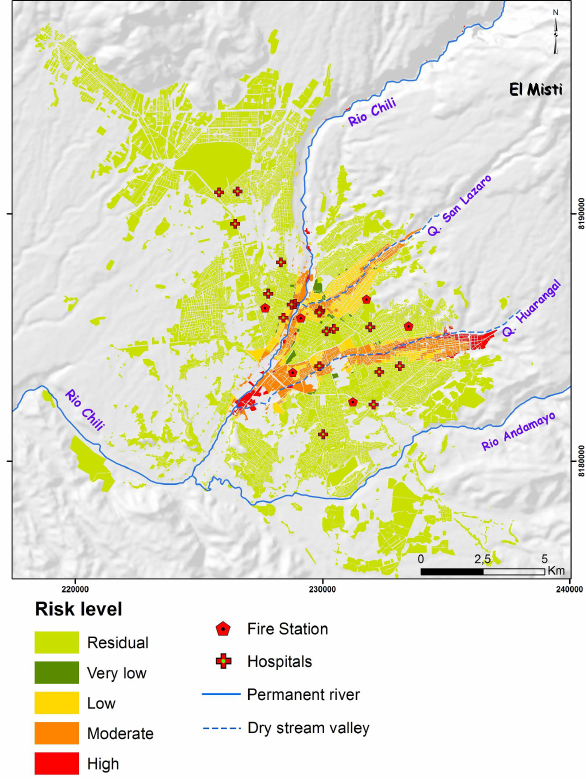
Fig. 13. Areas prone to lahar and flood risk in Arequipa. Areas prone to lahar and flood risk have been divided into five classes according to Table 8 (LRL). The scale of original data (city block) ensures a high level of precision. The figure takes into account flood and lahar risk only; hence only the river and Quebrada channels are at risk.